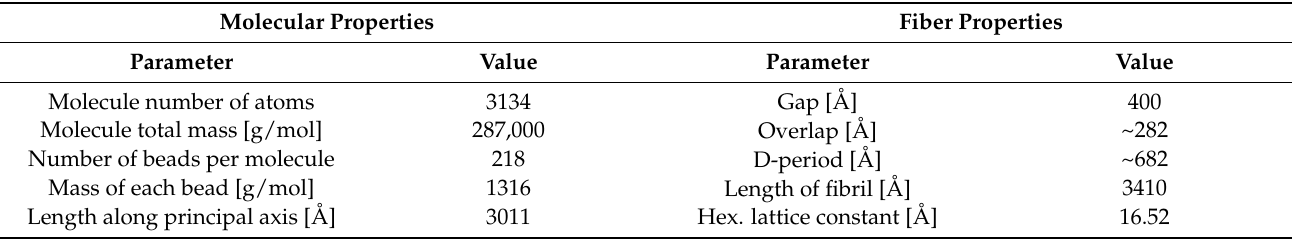
Table 1. Mesoscopic structural